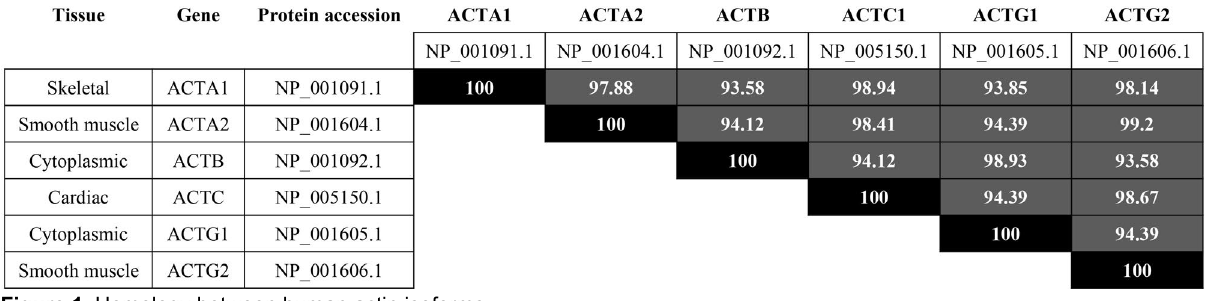
Figure 1. Homology between human actin isoforms Table 1. Main human β-actin phosphorylation